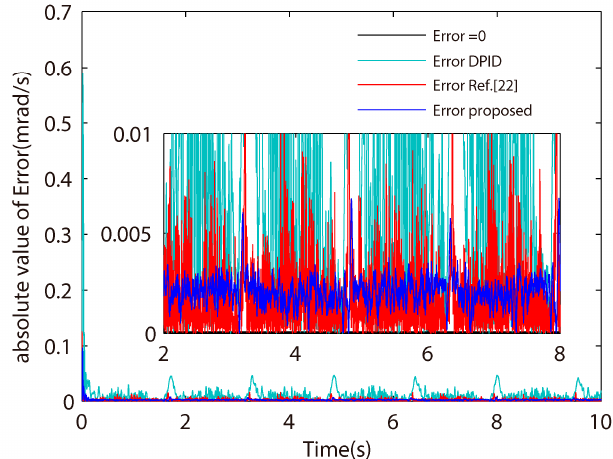
Figure 11. Absolute value of sinusoidal guidance error curve.